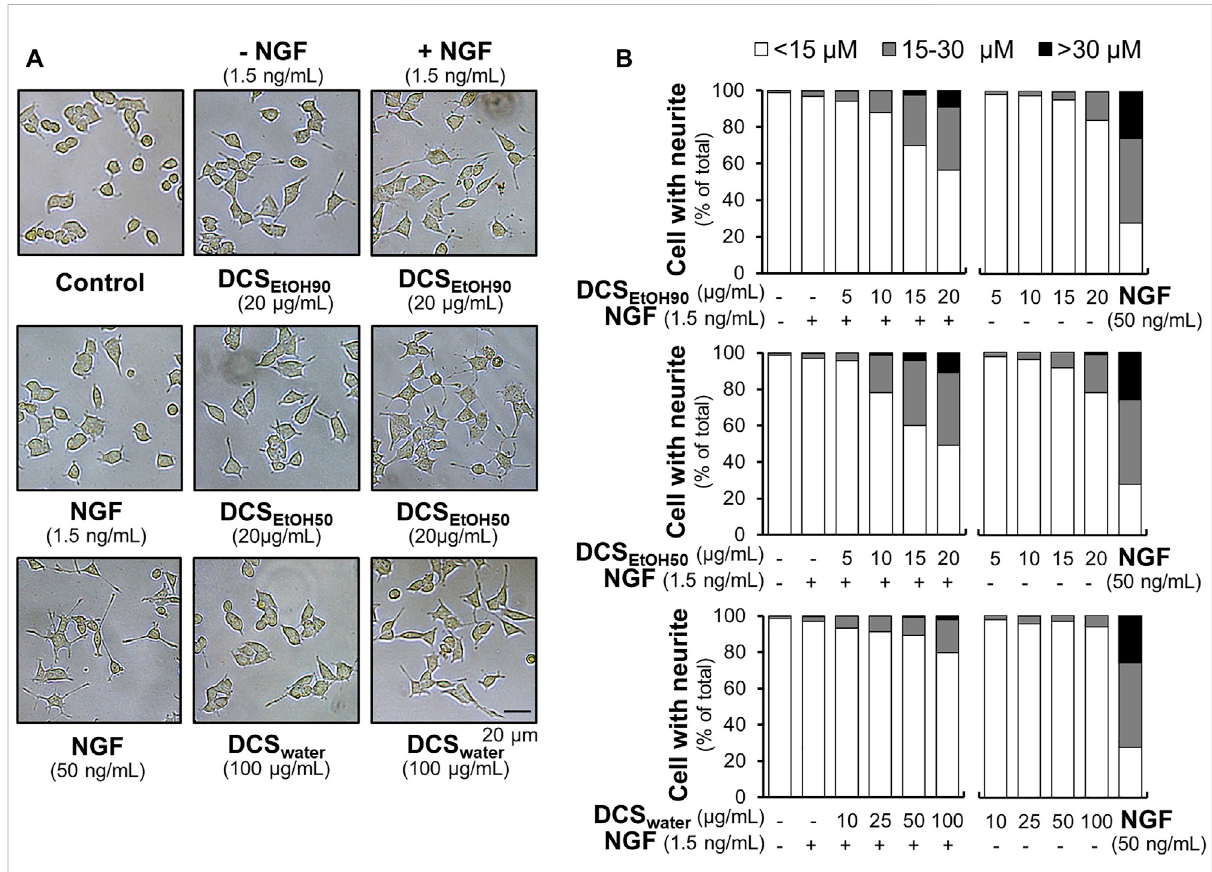
FIGURE 6 D. cochinchinensis stemwood extracts promote neurite outgrowth. (A) The morphology of PC12 cells was analyzed under a light microscope after 48 htreatmentofDCS EtOH90 ,DCS EtOH50 ,orDCS water withorwithout 1.5 ng/ml NGF.NGFataconcentrationof50 ng/ml wasusedas apositive control. (B) The length of the neurites was measured after 48 h of treatment with extracts in the presence or absence of 1.5 ng/ml NGF. The neurite length is presented as the percentage of cells with different neurite lengths in 100 counted cells, mean ± SEM for n =